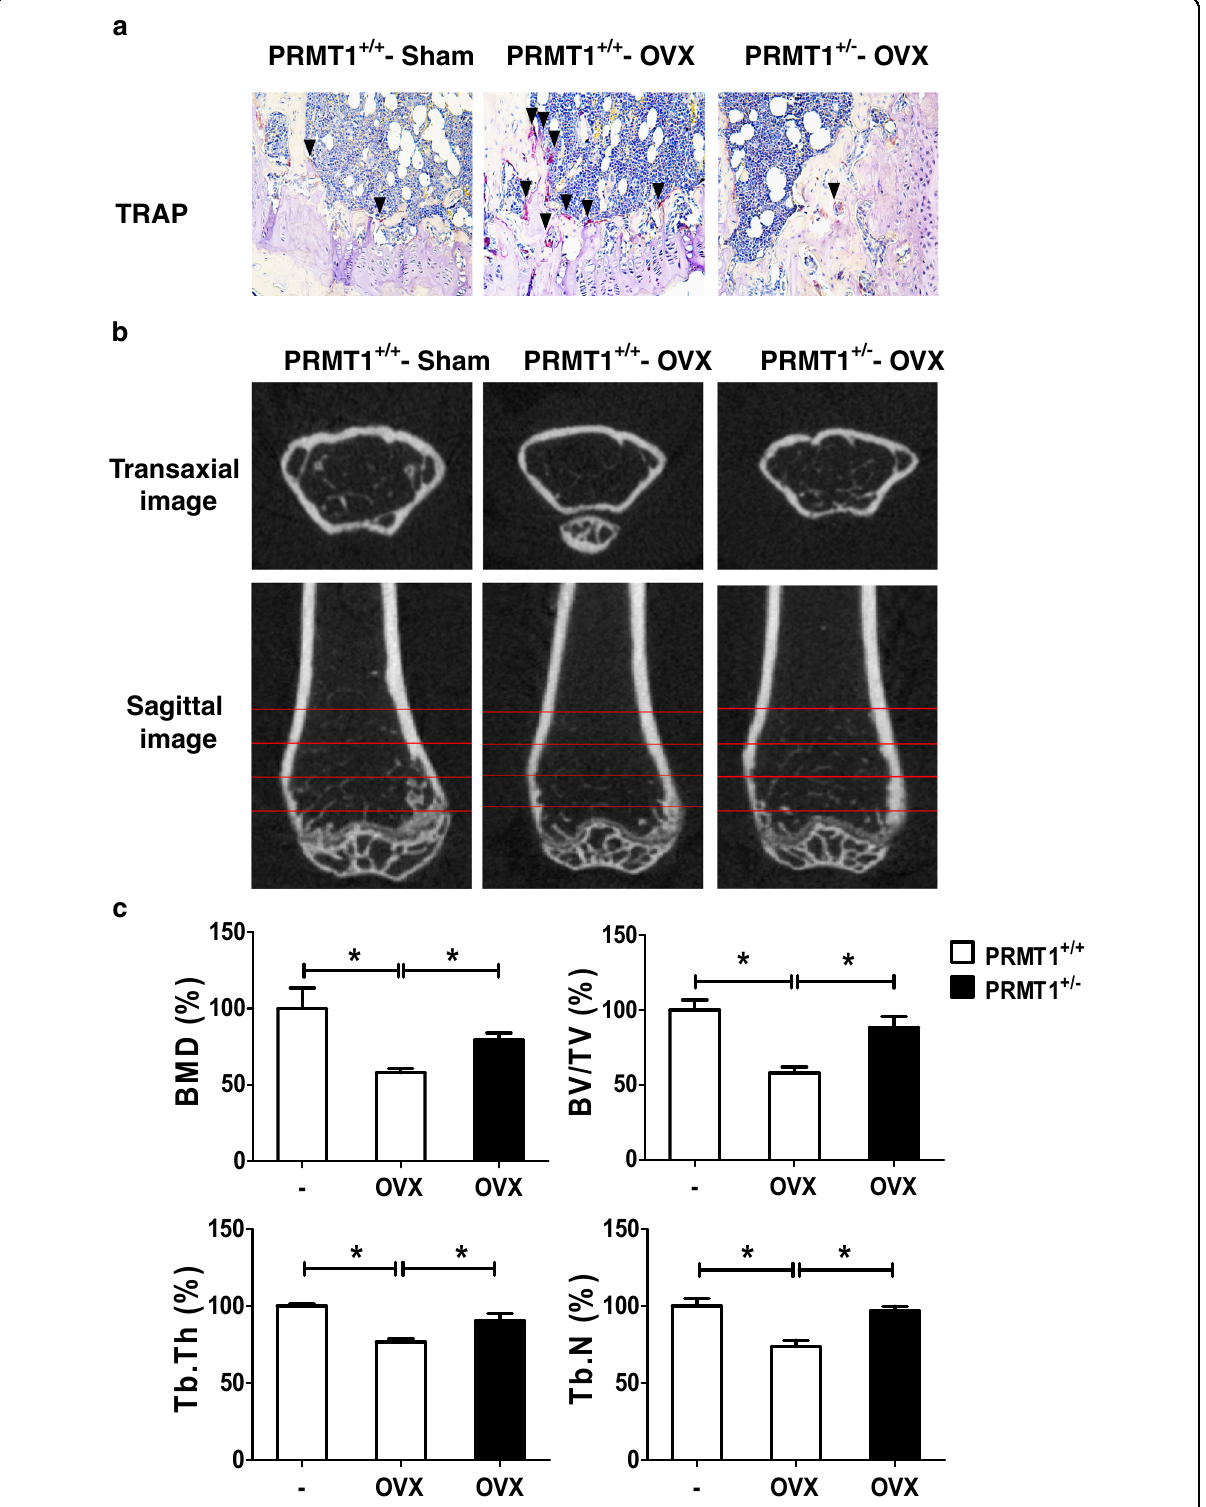
Fig. 6 PRMT1 haploinsuf fi ciency mice exhibit an anti-osteoporotic bone phenotype. a TRAP staining of distal portions of the femora were performed using leukocyte acid phosphatase kits and observed under a microscope (arrow). b The representative two-dimensional images of the femurs are shown. c The bone volume per tissue volume (BV/TV), trabecular number (Tb. N), trabecular thickness (Tb. Th) and bone mineral density (BMD) were assessed from μ CT measurements ( n = 6). * p <